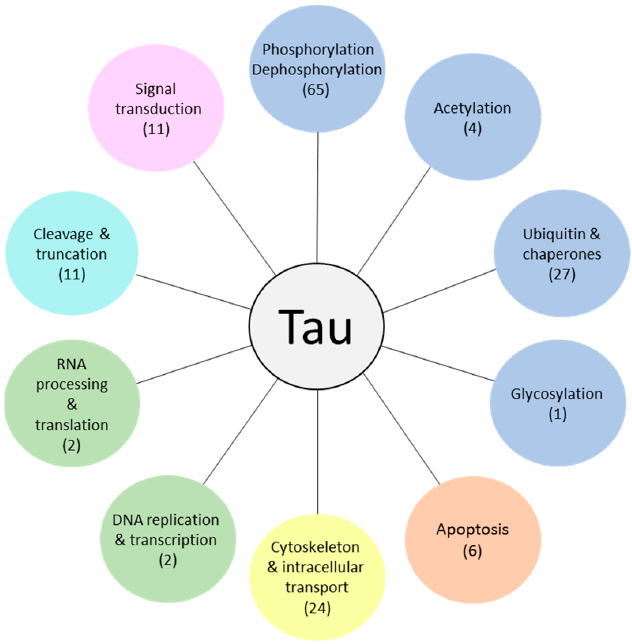
Figure 4. Overview of validated TIPs distributed according to their function. In brackets: the number of validated TIPs for the particular group.